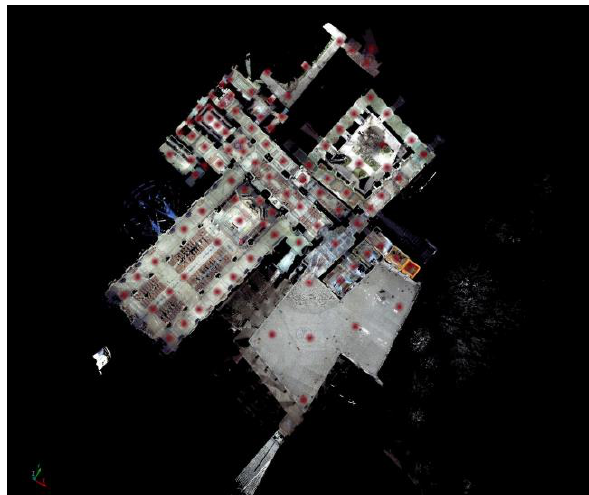
Figure 1. Distribution of laser scanner scanning points.